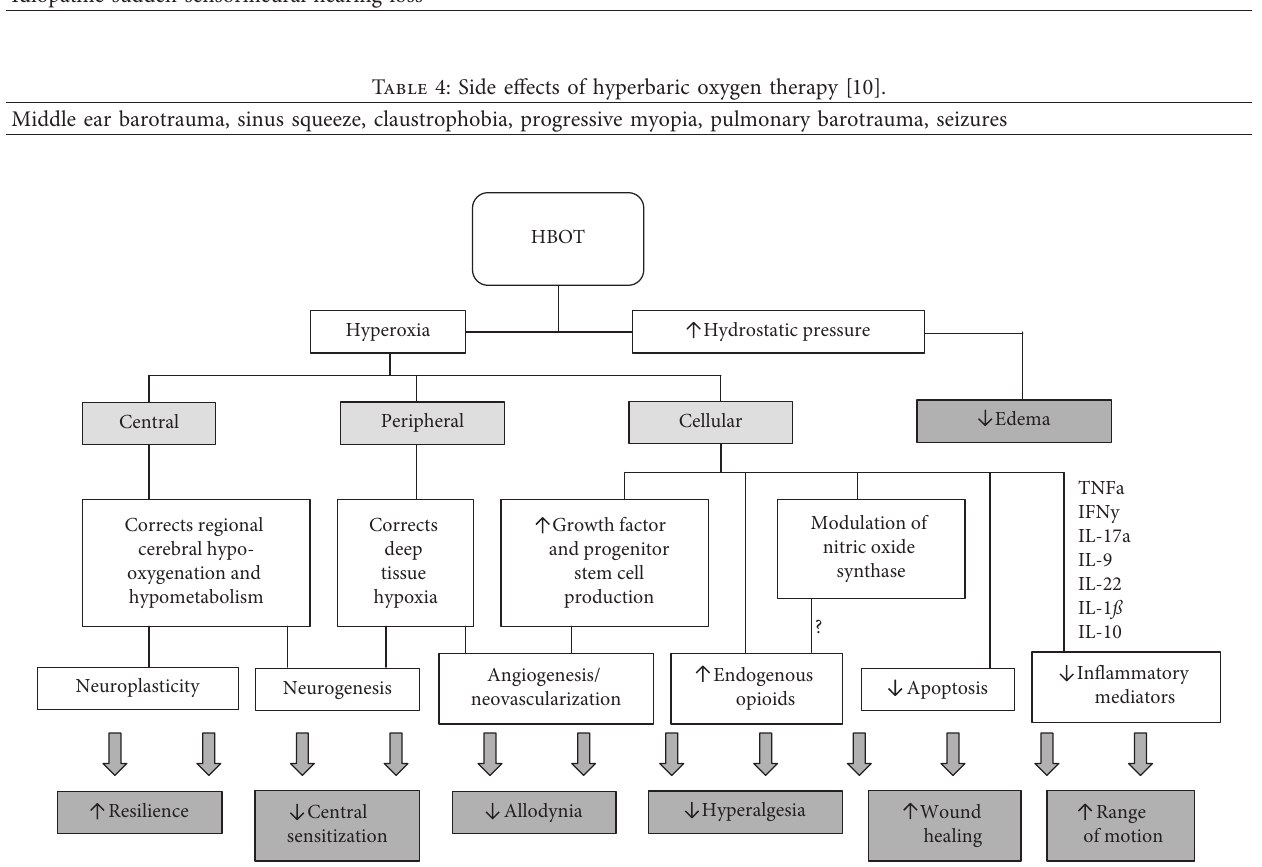
Figure 1: HBOTmechanisms and effect on chronic neuropathic pain disorders. HBOT:hyperbaric oxygen therapy; ROS: reactive oxygen species; RNS: reactive nitrogen species; TNF α : tumor necrosis factor-alpha; IFN c : interferon-gamma; IL: